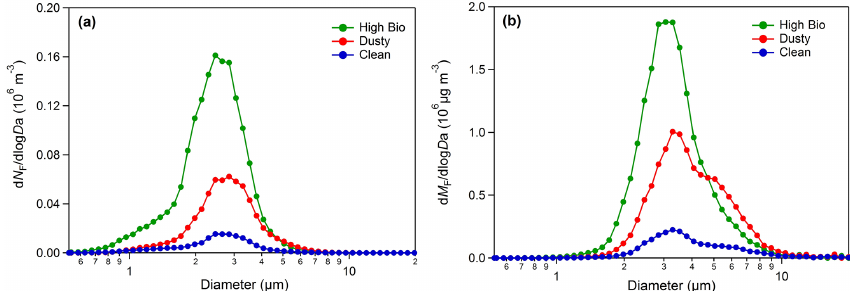
Figure 8. FBAP number (d N F / dlog D a ) and mass (d M F / dlog D a ) size distribution averaged over each distinct focus period during the measurement campaign carried out at Munnar. (a) Number size distribution and (b) mass size